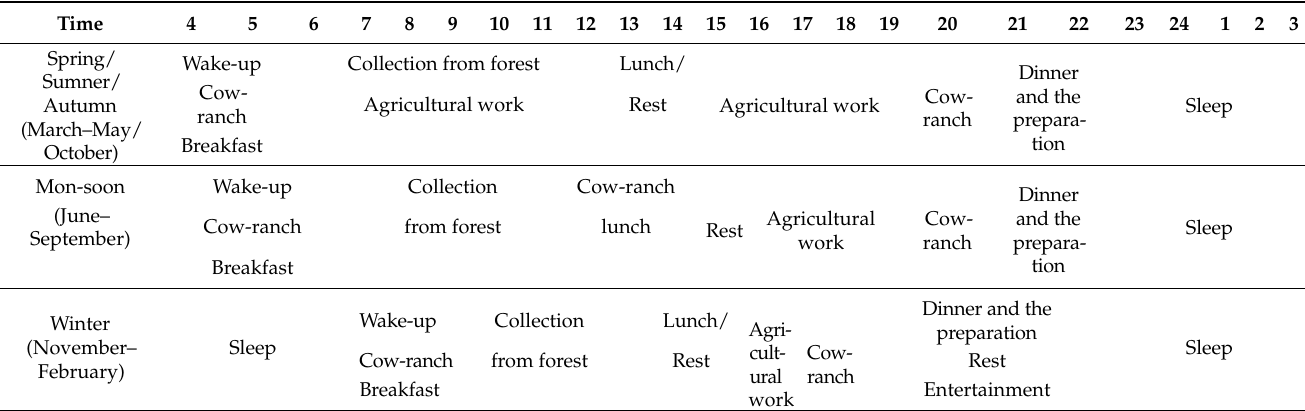
Table 6. Women’s daily work. Source: based on [38] and participant